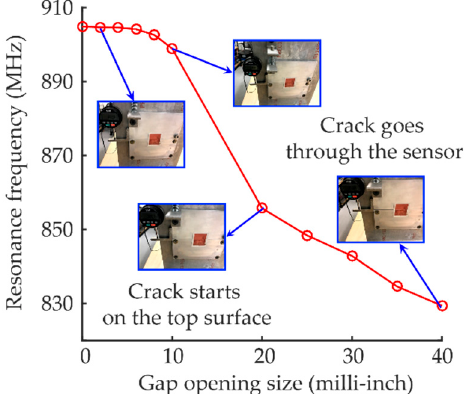
Figure 13. Resonance frequency f R versus gap opening size at dial gage